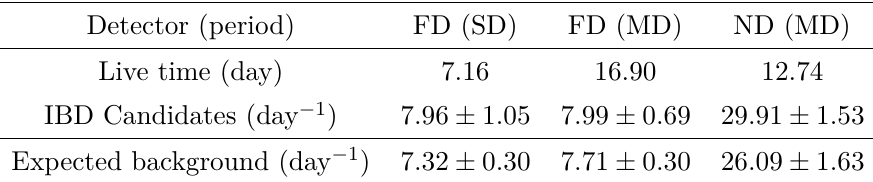
Table 2 . Reactor-off data samples during SD and MD. The last row shows the total background expectation between 1.0 and 8.5 MeV according to the model described in section 2, without con- sidering the residual ¯ ν e